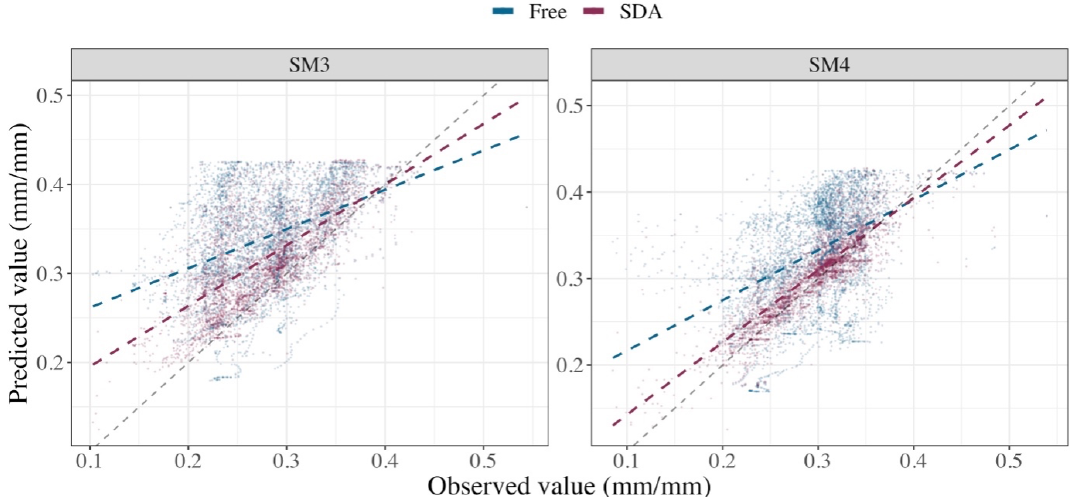
Figure 3. One-to-one plots for soil moisture estimates (mmmm − 1 ) in the two assimilation layers for the free model and in situ SDA across all analysis time steps and site years. The least-squares regression line is shown for both schemes next to the black dashed 1 : 1 line, demonstrating a perfect fit.